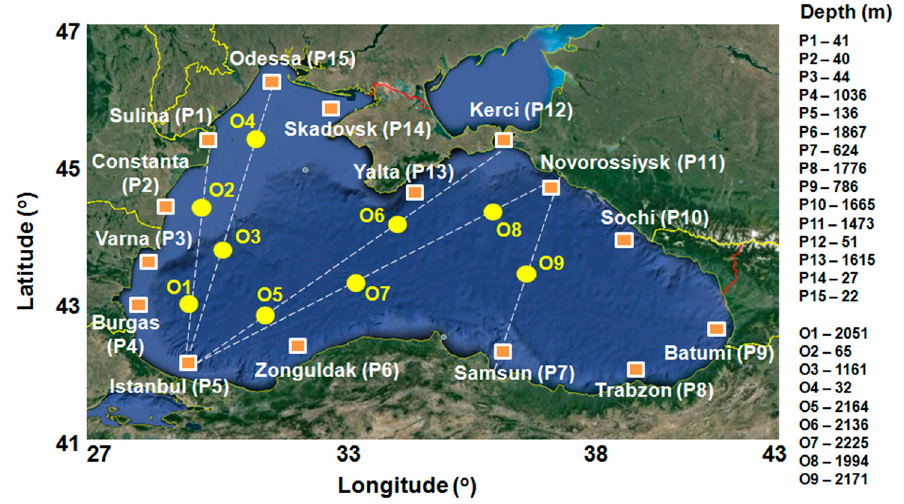
Figure 1. Map of the Black Sea and the reference sites; the points marked with squares (from P1 to P15) are located near the main harbors, while the points marked with circles (from O1 to O9) are located along the shipping routes. Table 1. Main characteristics of the considered sites.